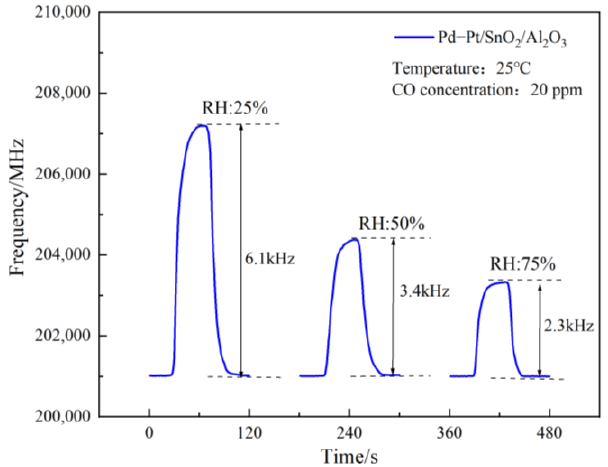
Figure 10. SAW sensor moisture sensitivity test.